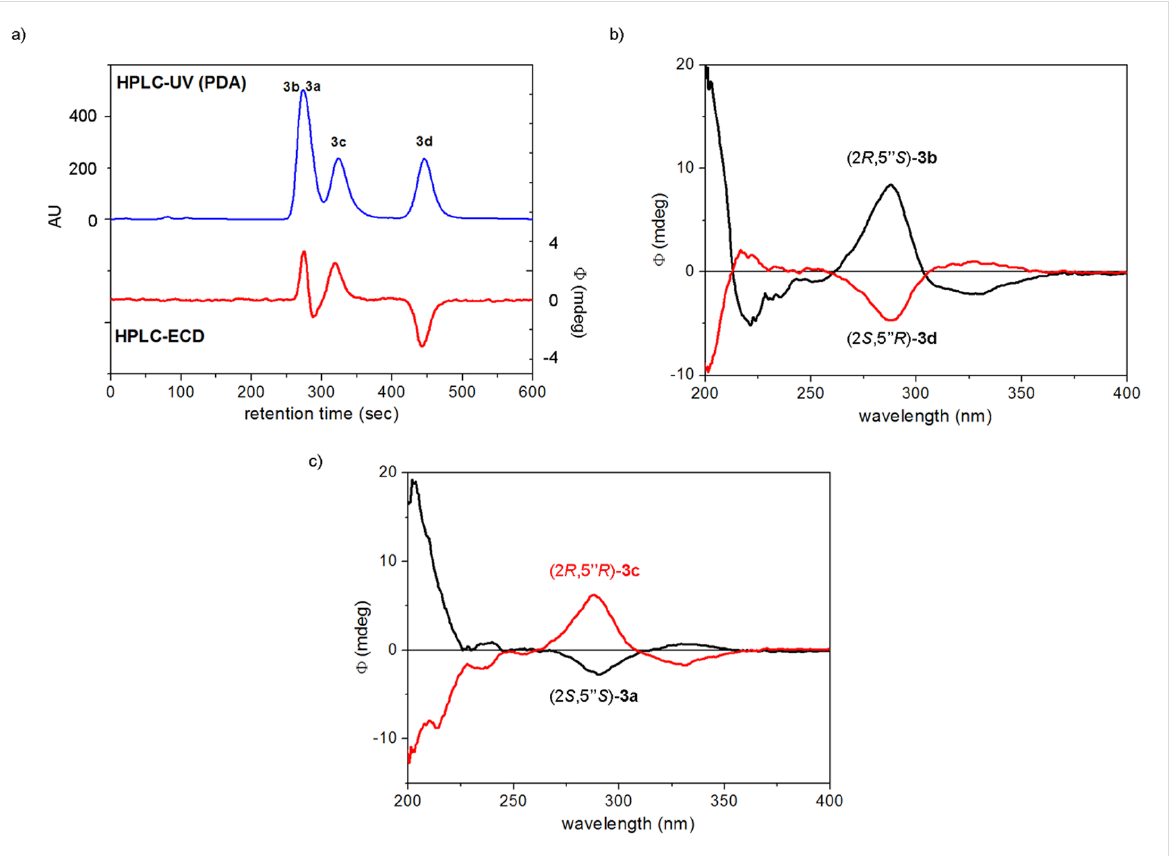
Figure 9: a) Chiral HPLC–UV and HPLC–ECD traces of dracocephins B1–B4 3a – d using a Chiralpak IC column with the eluent MeCN/2-propanol/ TFA 90:10:0.1 monitored at 285 nm. b) HPLC–ECD spectra of the first- [black: (2 R ,5” S )- 3b or dracocephin B2] and fourth eluted [red: (2 S ,5” R )- 3d or dracocephin B4] stereoisomers of dracocephins B. c) HPLC–ECD spectra of the second [black: (2 S ,5” S )- 3a or dracocephin B1] and third eluted [red: (2 R ,5” R )- 3c or dracocephin B3] stereoisomers of dracocephins B. The absolute configurations were assigned on the basis of the publication of Ren et al. [2].